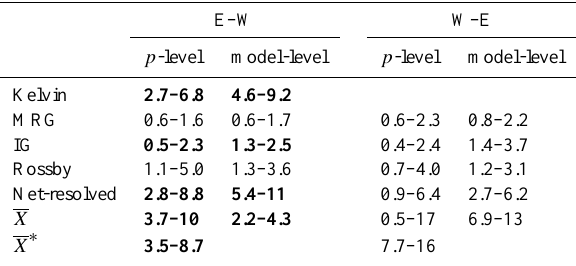
Table 3. The same as in Table 2, except at 50hPa. Table 4. The same as in Table 2, except at